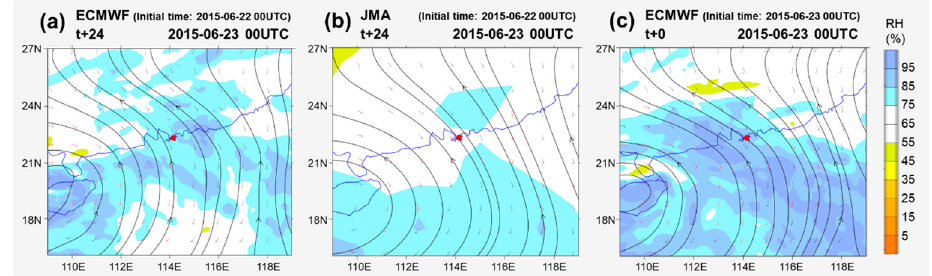
Figure 15. ( a , b ) The predicted 500 hPa moisture (RH shaded) and wind fields (streamlines) of ( a ) ECMWF, ( b ) JMA for 23 June 2015 00 Z. ( c ) Ground truth of the same time based on ECMWF analysis field.